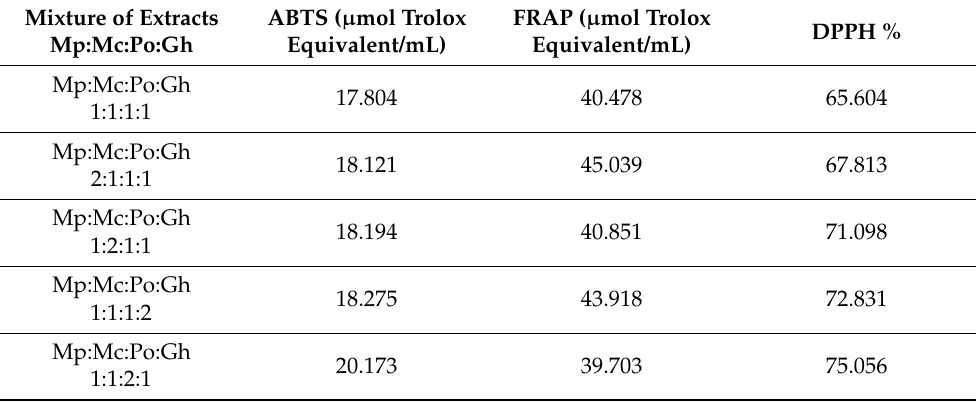
Table 2. Antioxidant activity determined by the three chemical methods of the samples, Mentha